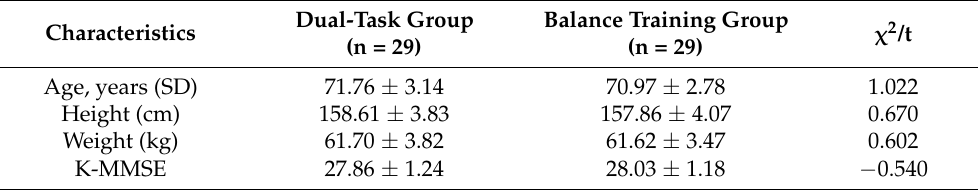
Table 3. General characteristics of participants (N = 58).